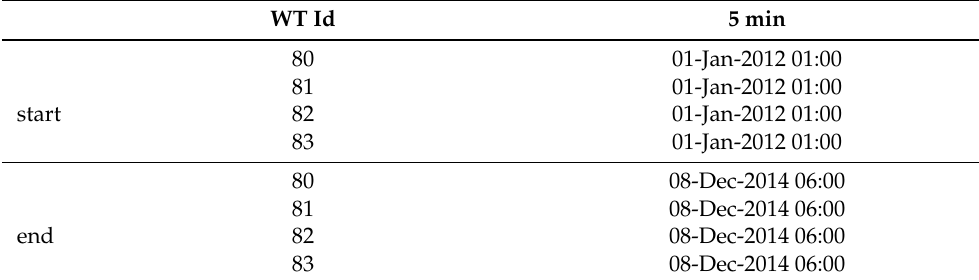
Table 1. Temporal distribution of data and turbine